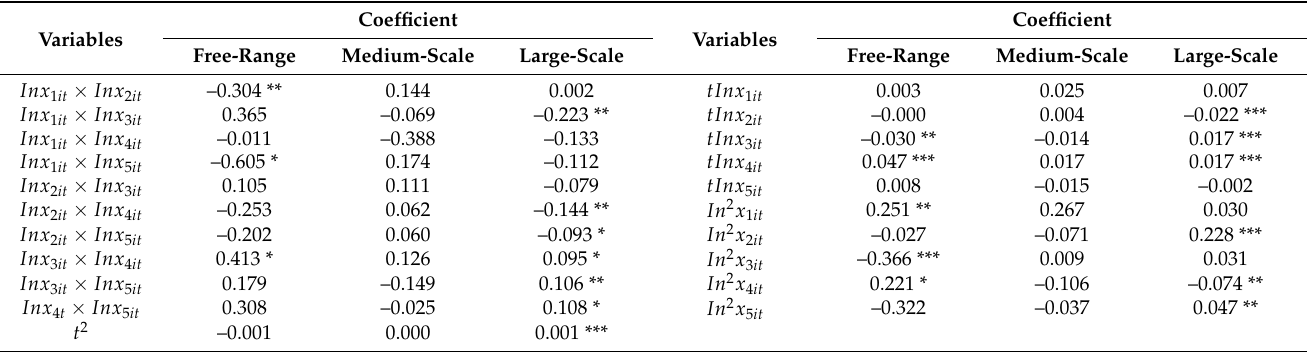
Table 5. Parameter estimation and test of the quadratic terms of the SFA